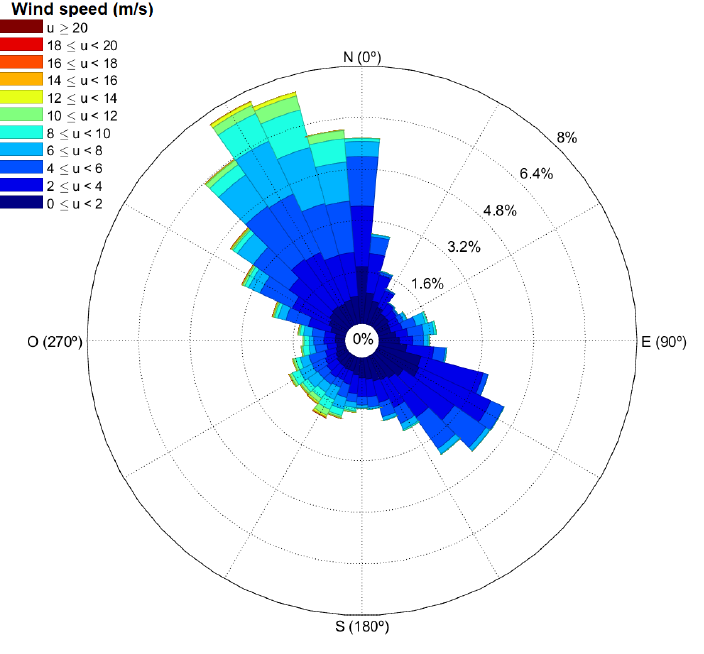
Figure 1. Wind rose for the case study